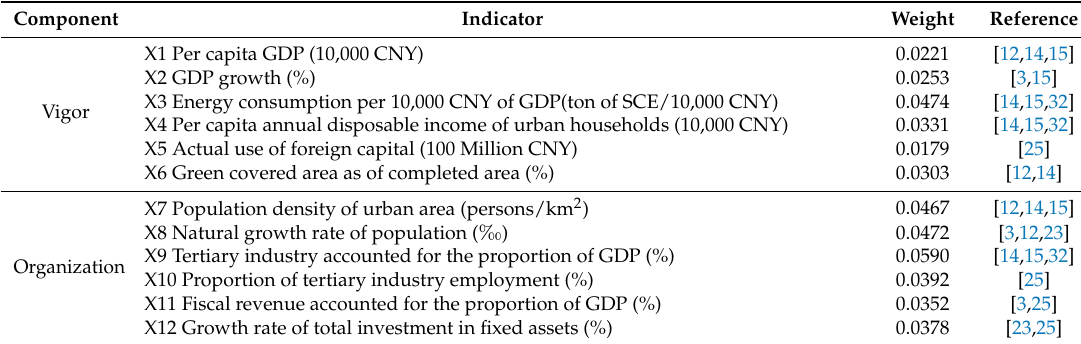
Table 2. Weight and assessment indicator system of